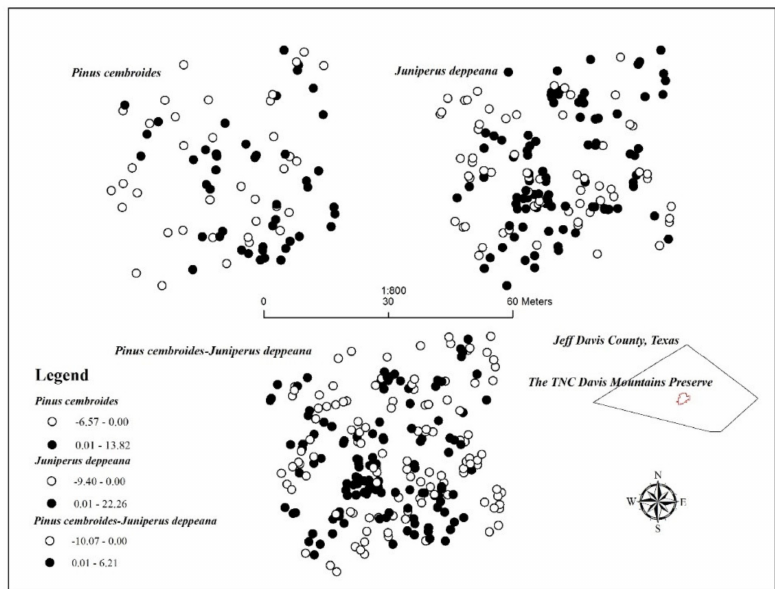
Figure 7. Anselin Local Moran’s I values for Mexican piñon ( Pinus cembroides var. cembroides Zucc.) (top left), alligator juniper ( Juniperus deppeana var. deppeana Steud.) (top right), and piñon–juniper (bottom middle) age data for 1965, 1985, and 2005 within study site 2. Trees of relatively similar age are presented by black circles, whereas trees of relatively dissimilar age are presented by open